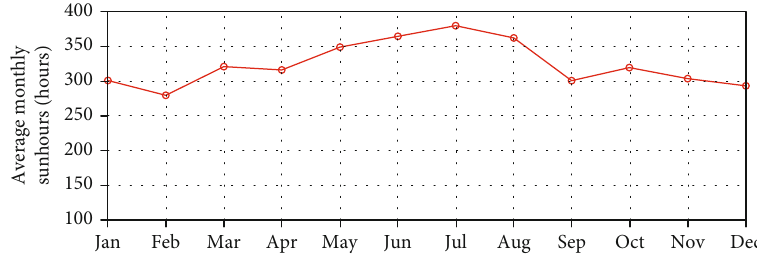
Figure 9: Average monthly sun hours at Aswan city